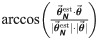
The averaged angle error, arccos(θ→Nest⋅θ→∣θ→Nest∣⋅∣θ→∣), between the estimation θ→Nest, which depends on the number of flow vectors N, and the true values θ→, is shown for translation (solid lines) and rotation (dashed lines).Red curves show the errors for original KvD algorithm, green curves for the modified KvD algorithm. The errors are averaged over 40 trials (see methods 4.3). For each trial the true self-motion parameters are chosen randomly, equally distributed over the sphere, in such a way, that the resulting translational flow equals the resulting rotational flow in magnitude. The distances, also determined randomly, lie with equal probability between one and three in arbitrary units. The results for three different variances (△p→)2 are shown (from bottom to top): 1, 3, and 9 times the flow vector length, where the factor is interpreted differently in the two graphs. A) Results for non-equally distributed flow vectors with equal variance of the flow vector errors △p→i (the variance is matched to the mean flow vector). B) Results for equally distributed flow vectors, where the variance of the errors △p→i depends linearly on the length of the p→i (the variance is matched to the local flow vector).